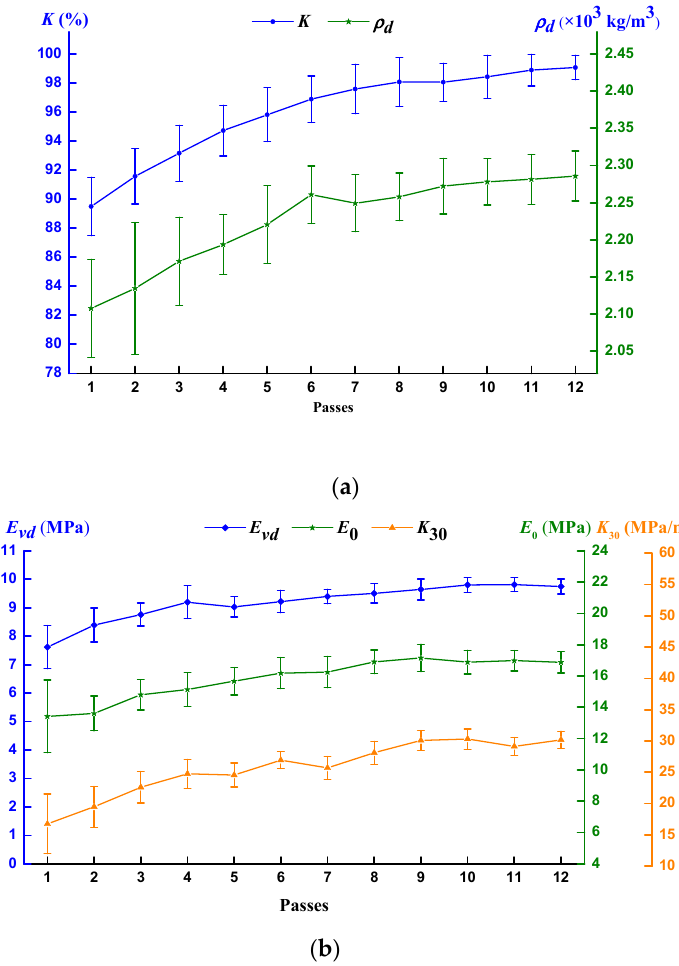
Figure 7. Relationship of compaction passes with the indices and the mean errors of test points: ( a ) physical indices; ( b ) mechanical indices.